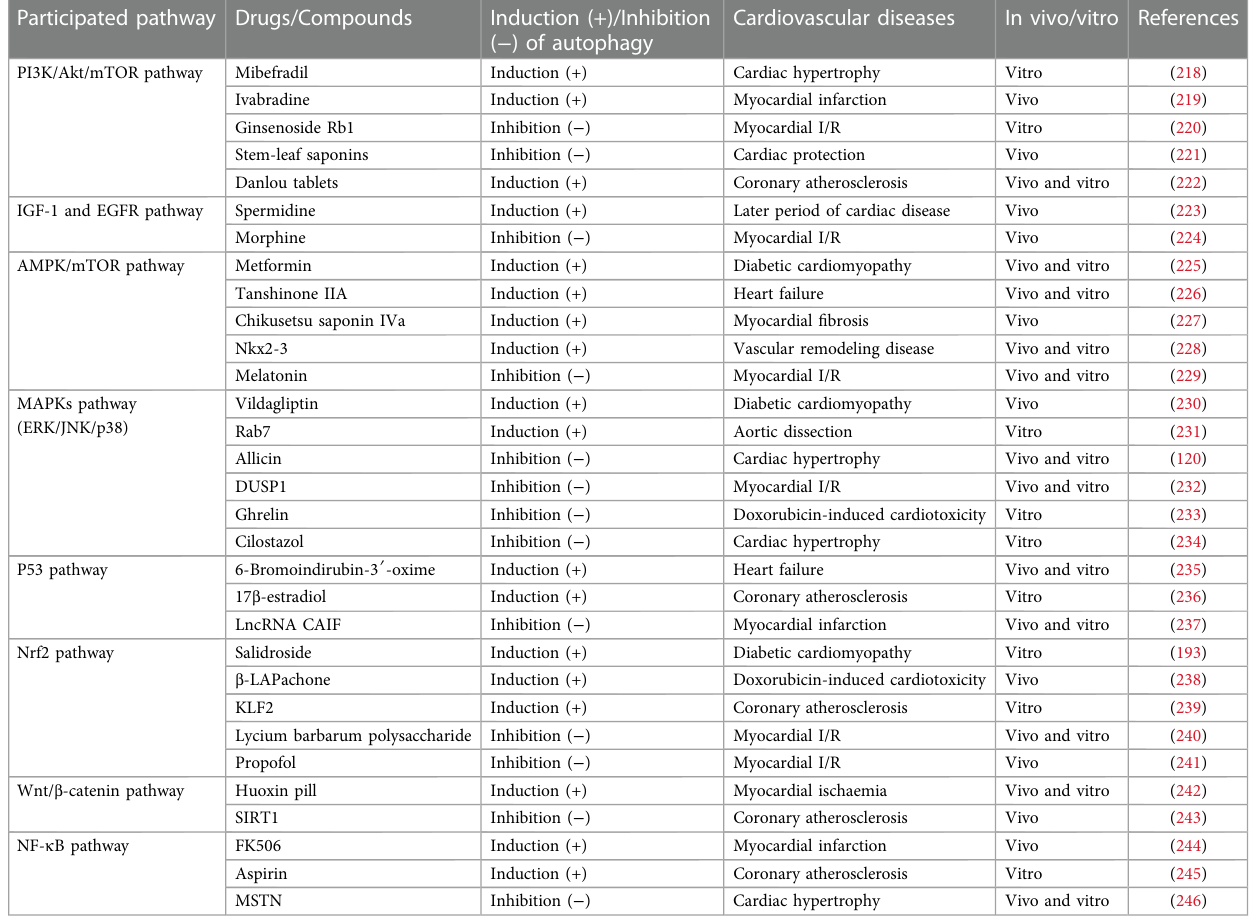
TABLE 3 Targeting autophagy as a therapeutic strategy for cardiovascular diseases via signaling